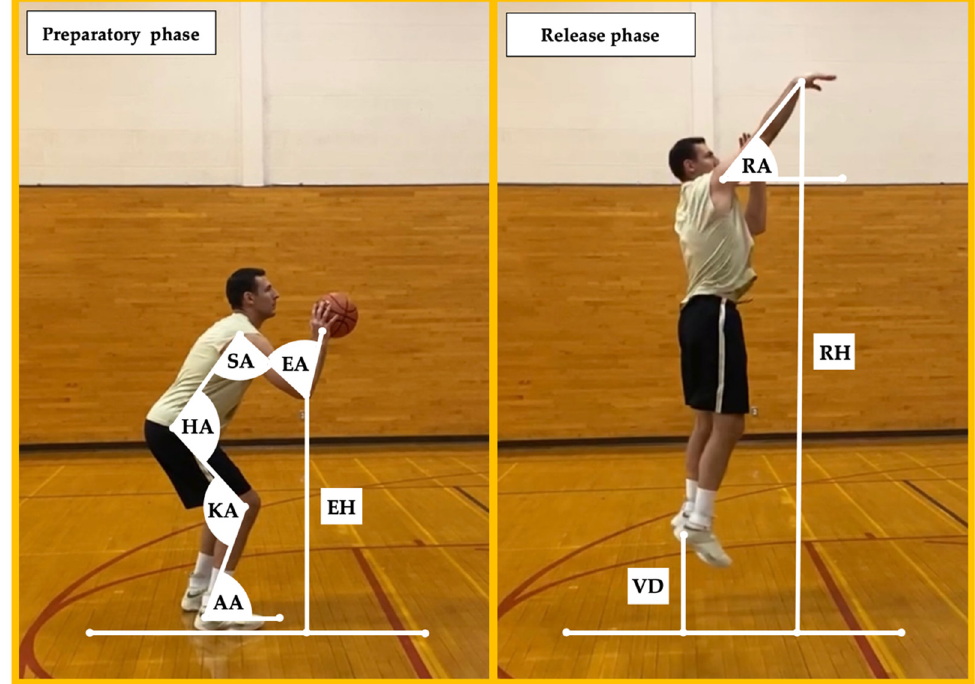
Figure 1. Graphical representation of kinematic variables examined in the present study. KA = knee angle, HA = hip angle, AA = ankle angle, EA = elbow angle, SA = shoulder angle, EH = elbow height, RA = release angle, RH = release height, and VD = vertical displacement.